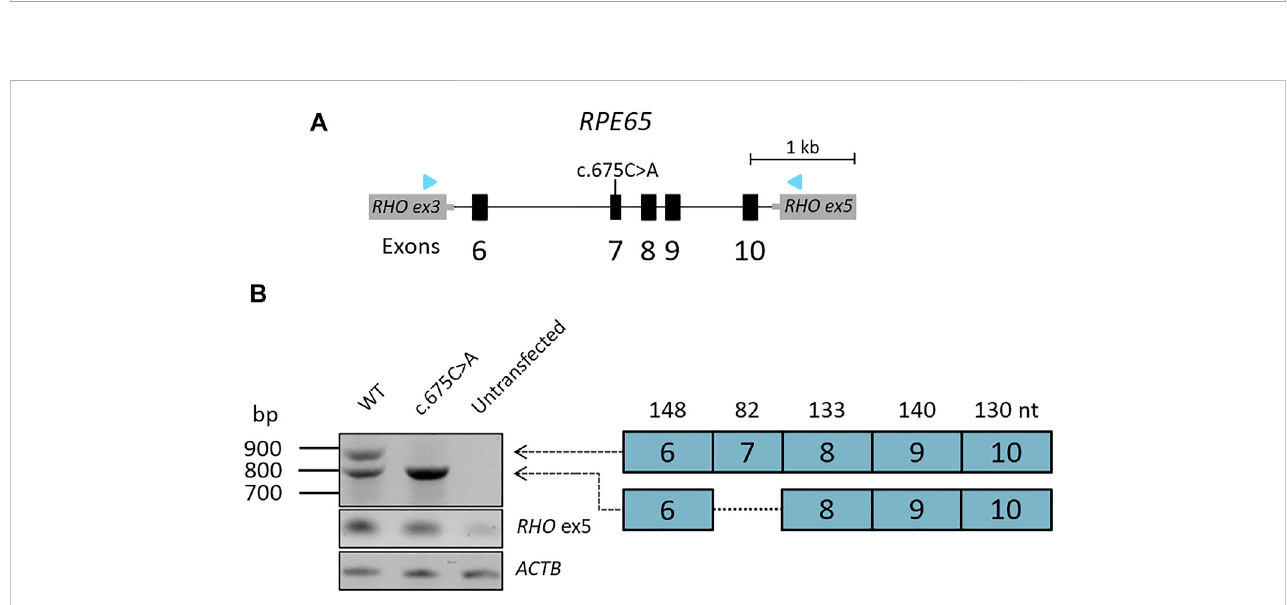
FIGURE 4 Minigene analysis of the splicing effect of RPE65 :c.675C > A. (A) A minigene construct containing either wild-type sequence or the mutant c.675C > A variant in exon 7 was generated spanning exons 6-10 of RPE65 and was fl anked by exons 3 and 5 of the RHO gene in the pCI-NEO-RHO vectors (B) After gel electrophoresis of the RT-PCR product, we observed two fragments in the wild-type situation. One fragment of 907 nt and one fragment of 825 nt corresponding to the skipping of the 82 nt exon 7. For 675C > A, we exclusively observed the 825 nt fragment, suggesting complete skipping of exon